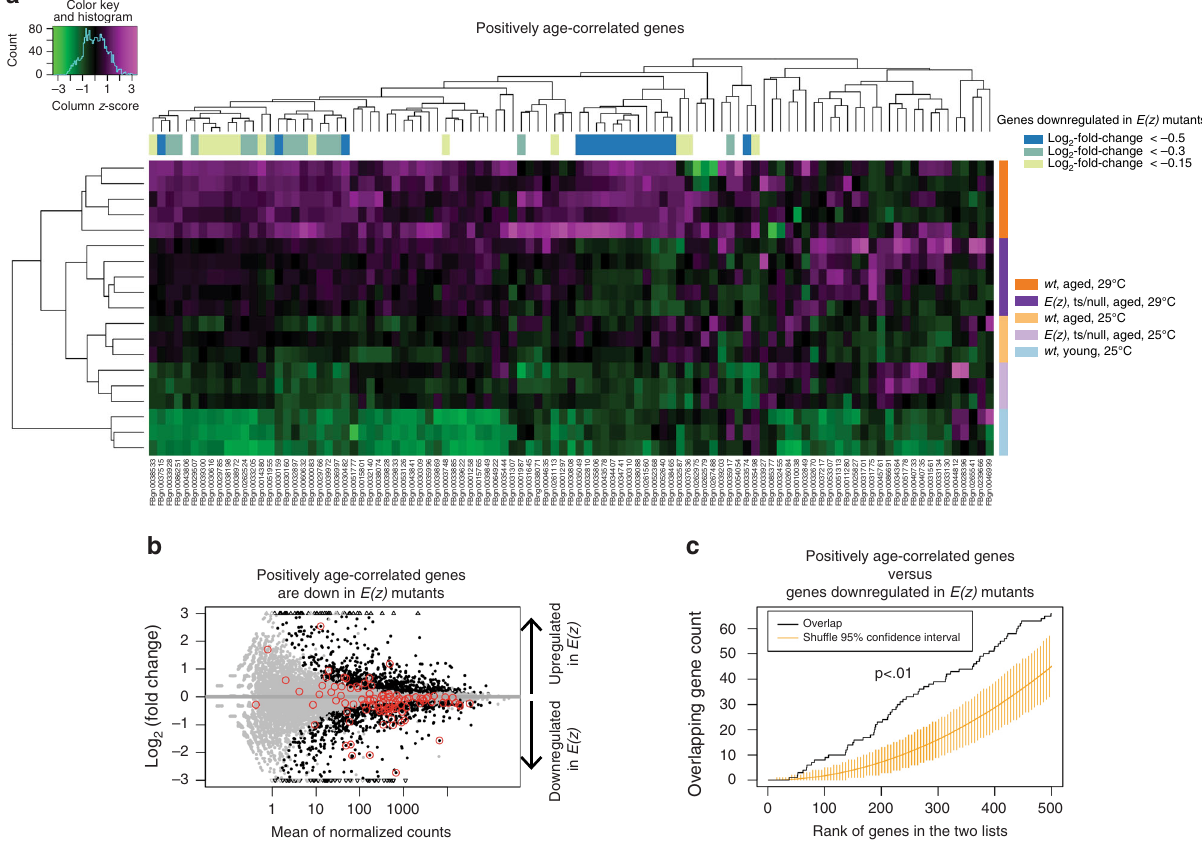
Fig. 8 E(z) mutants have a chronologically younger aged transcriptome. a Heatmap of positively age-correlated genes. A set of genes previously shown to be positively correlated with age in the Drosophila brain 6 were analyzed using hierarchical clustering to assess their pattern of expression in the E(z) mutant combination. Magenta indicates high and green indicates low expression. Colored bars on the side indicate genotype, age, and temperature. Colored